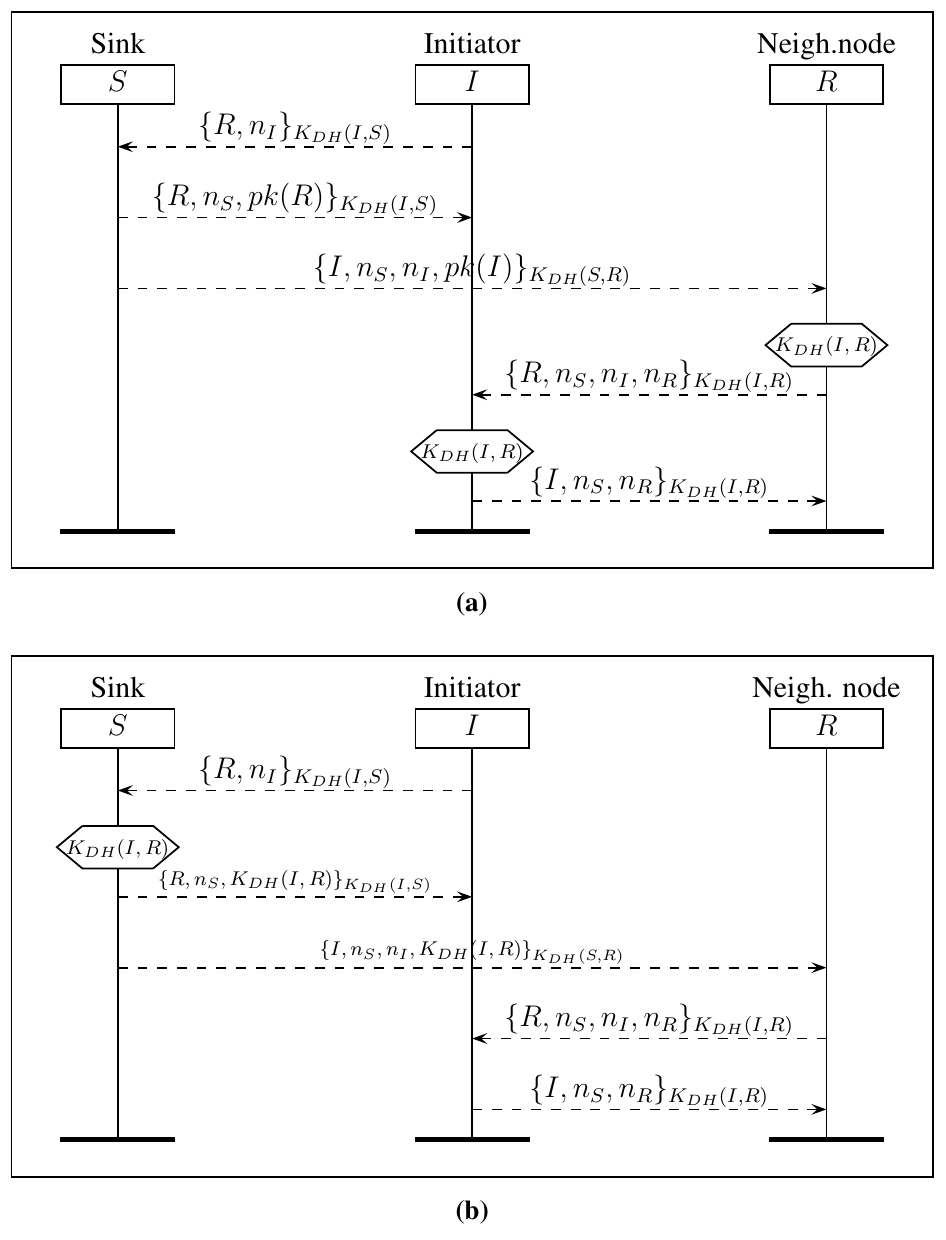
Figure 7. Protocols for the multihop shared key. ( a ) Protocol MSK